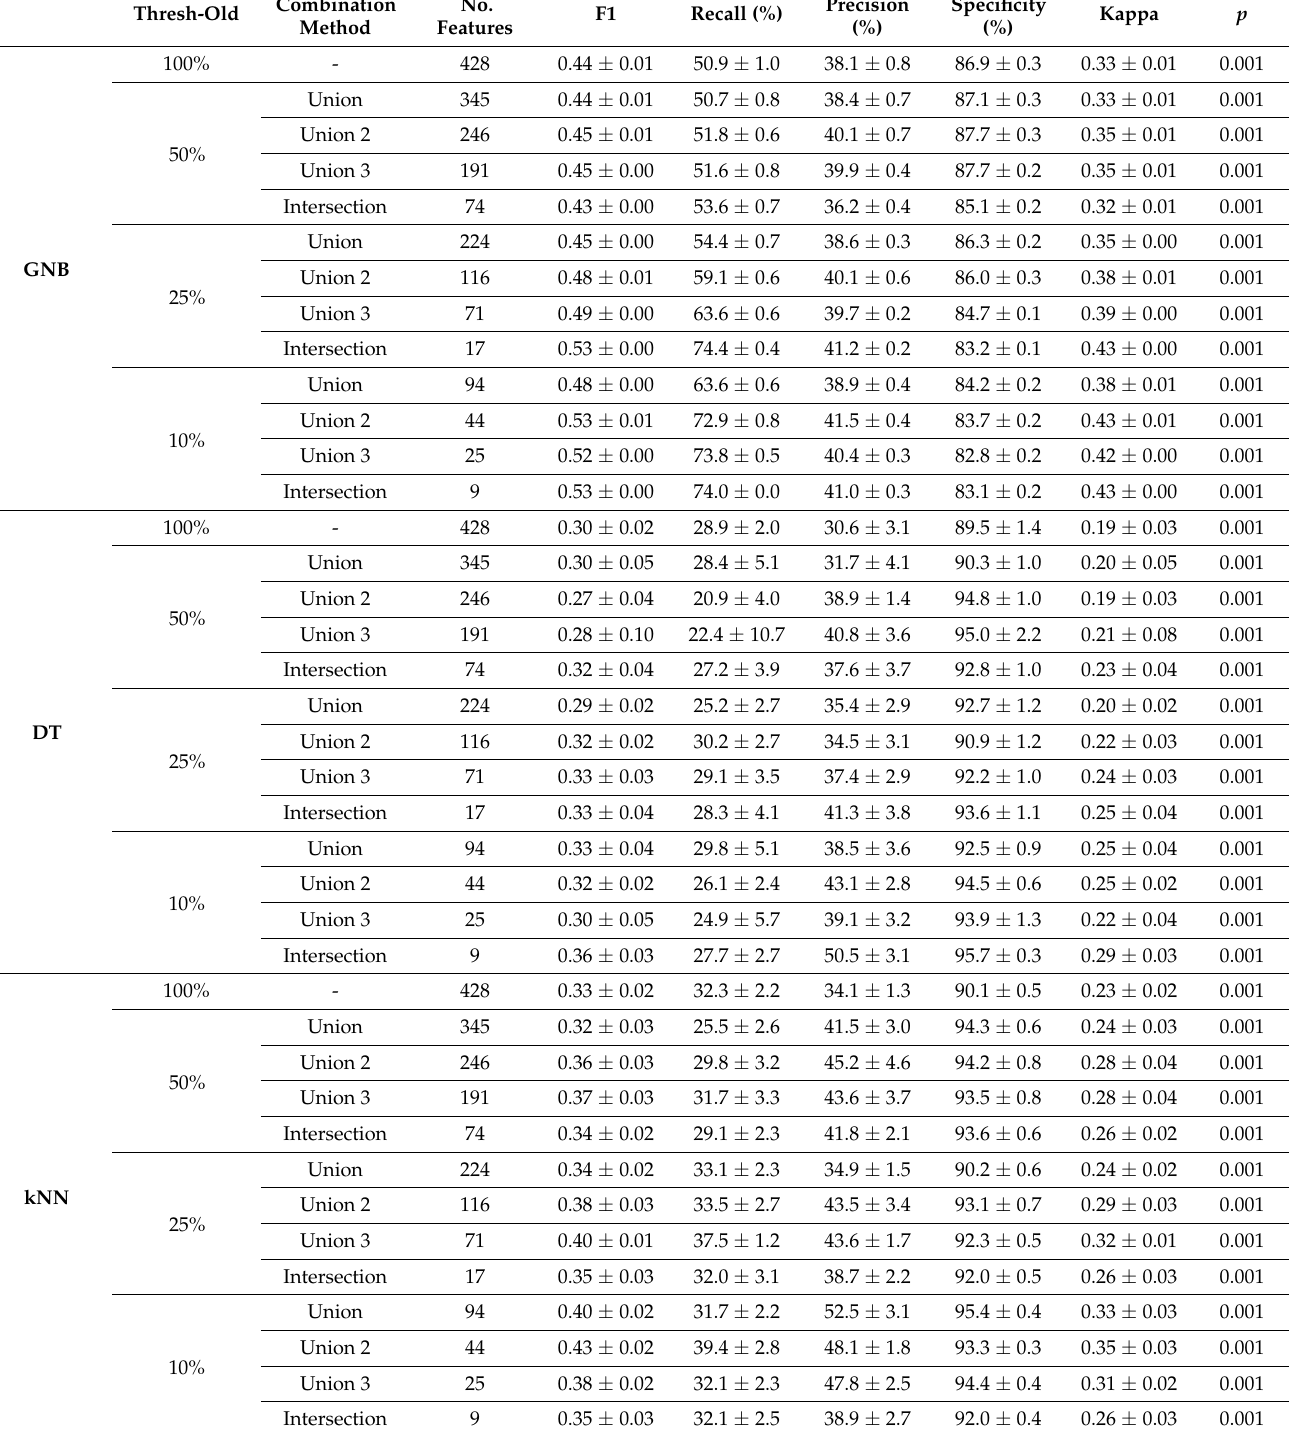
Table A2. Performance of the four classification models on detection fall using all data; Gaussian Naive Bayes (GNB); Decision Tree (DT); k-Nearest Neighbor (kNN); Support Vector Machine (SVM); p -value via permutation